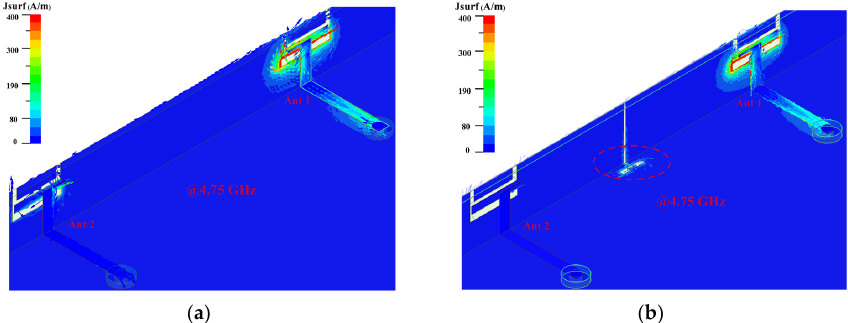
Figure 8. Surface current distributions when Ant 1 is excited. ( a ): Without decoupling structure and ( b ): with decoupling structure.